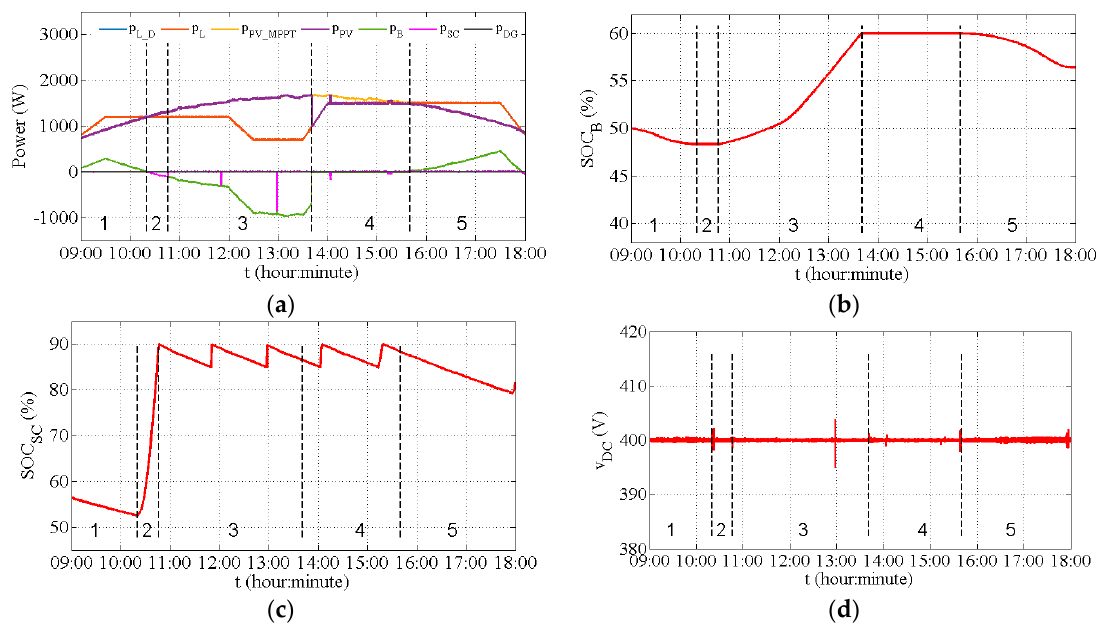
Figure 11. Experimental results of test 3: ( a ) DC microgrid power evolutions, ( b ) SOC evolution of electrochemical battery bank, ( c ) SOC evolution of the SC, and ( d ) DC bus voltage.